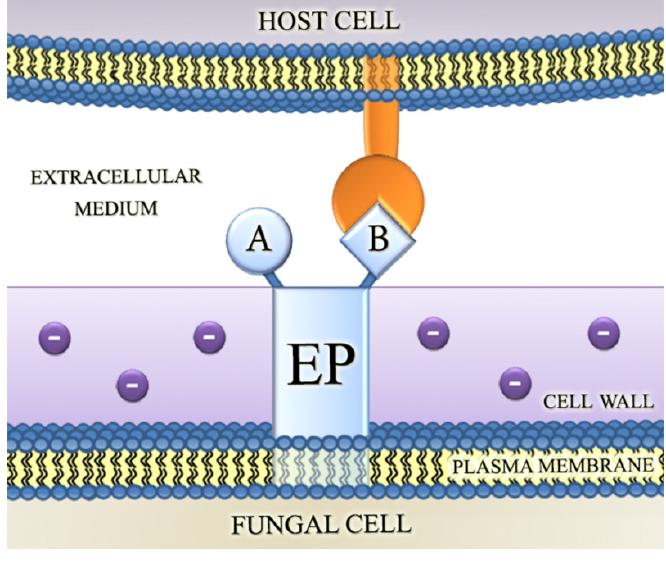
Figure 3. Ectophosphatase may contain adhesive domains that could directly promote the attachment of fungal cells to their hosts. In addition to the catalytic domain, ectophosphatase may also exhibit an adhesion domain, thus functioning similarly to the well-characterized microbial adhesins. Abbreviations: EP, ectophosphatase; A, catalytic domain; and B, adhesion